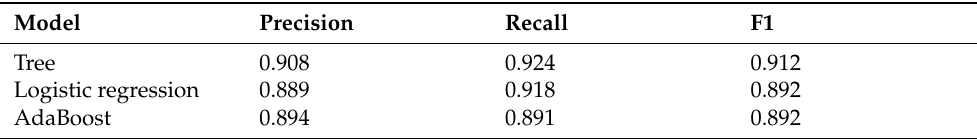
Table 3. Results of cross-validation with small-scale model.